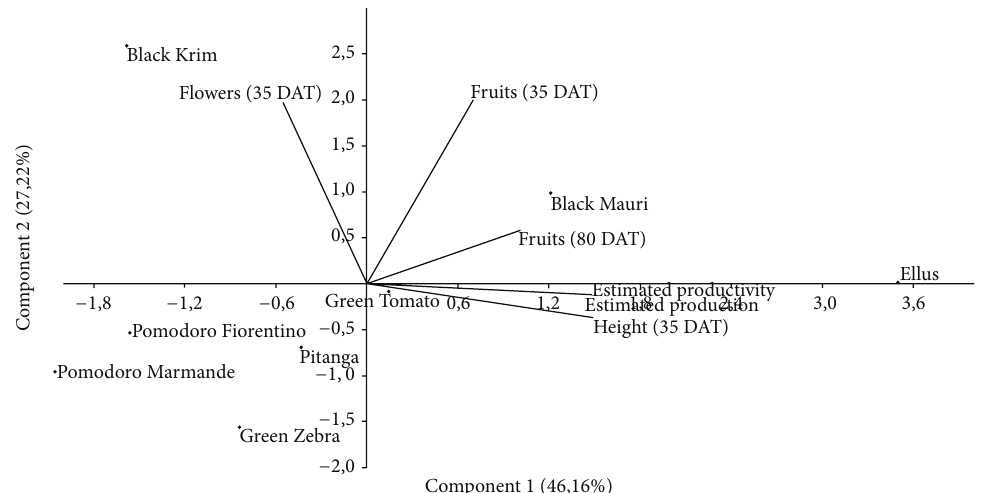
Figure 1: Biplot of plant variables (height, flowers, number of fruits, and production) and tomato genotypes relative to principal components 1 and 2.